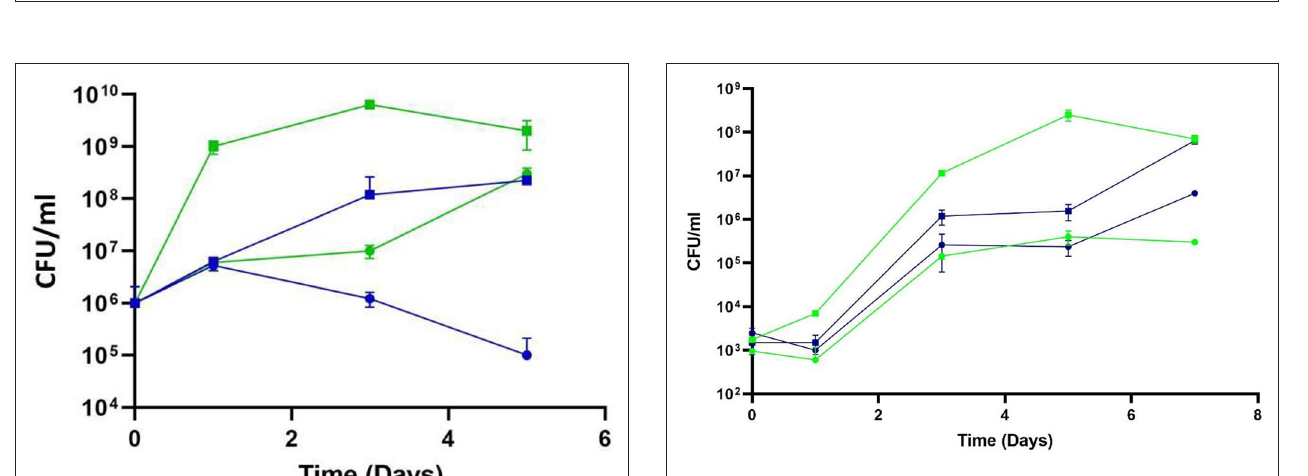
7. When stored at 8 ◦ C a reduction of 1.2 log (93.75% reduction)